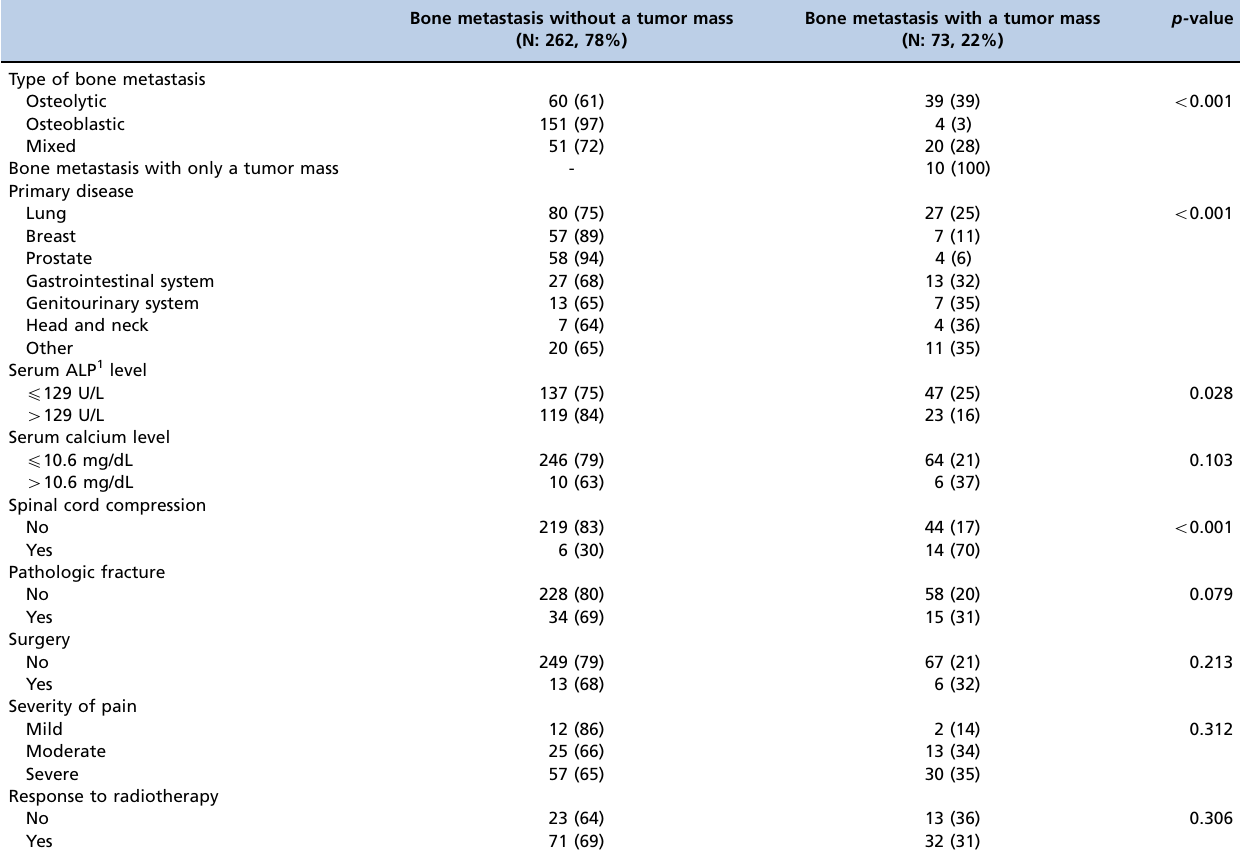
Table 1 - Comparison of features associated with bone metastases with or without tumor masses.